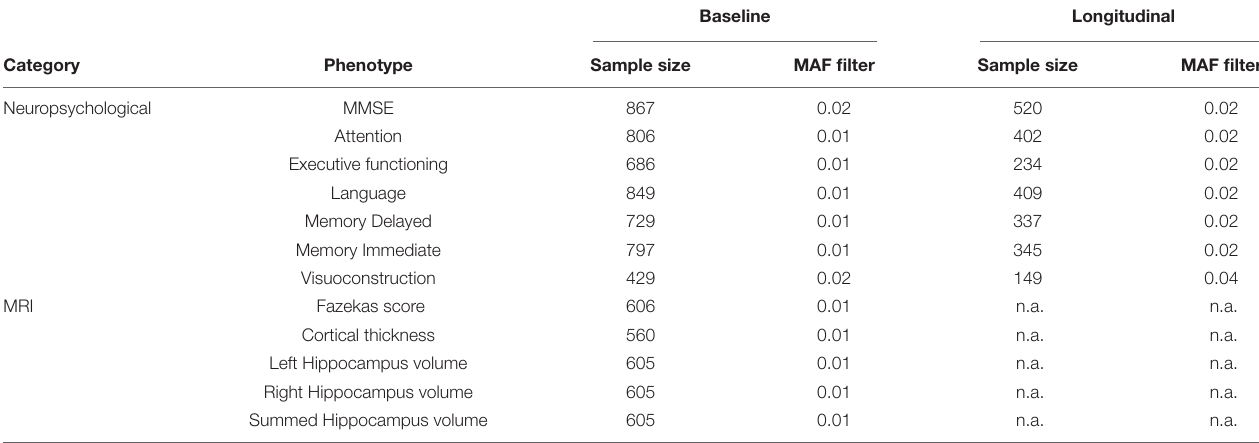
TABLE 1 | Description of EMID-AD MBD datasets analyzed per